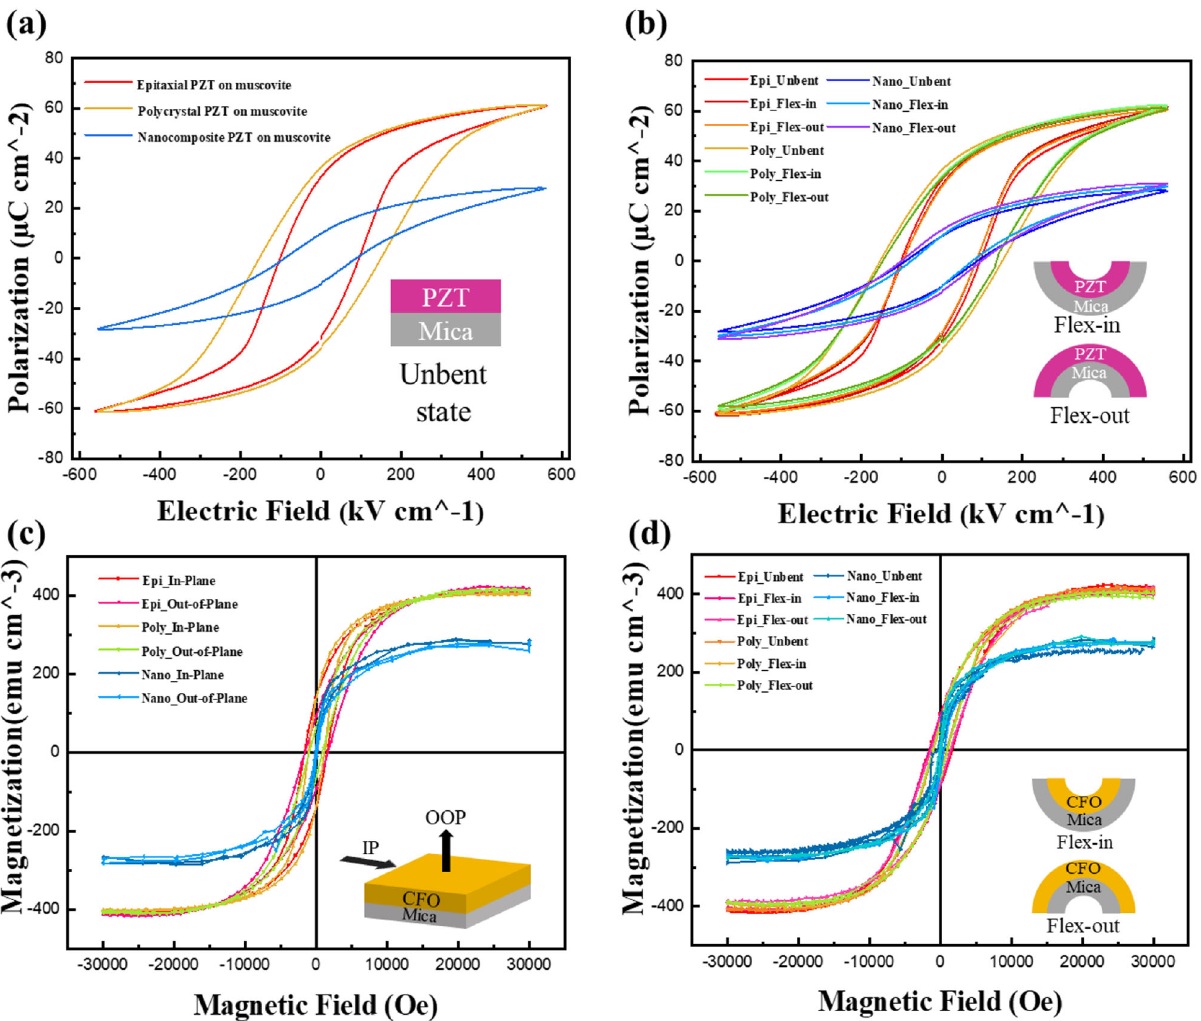
Fig. 3 The PE loop and MH loop measurements for three samples on the muscovite substrate. a , b PE loop measurement for PZT in unbent conditions and under compressive and tensile constraints. c MH loop for CFO along OOP and IP directions without bending. d MH loop for CFO under bending condition along OOP